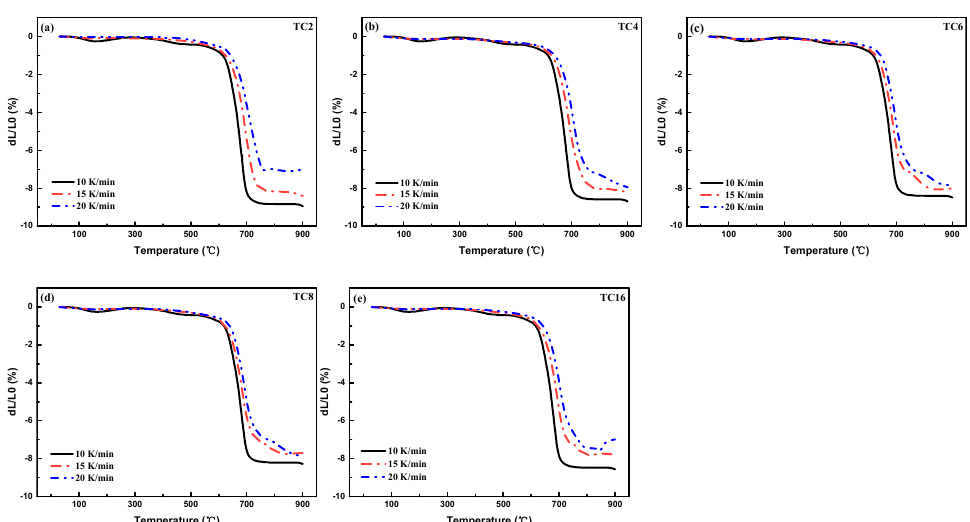
Figure 5. Shrinkage curves for TTC composite with various TC contents sintered at 950 °C for 1 h, ( a ) TC2, ( b ) TC4, ( c ) TC6, ( d ) TC8, and ( e ) TC16.